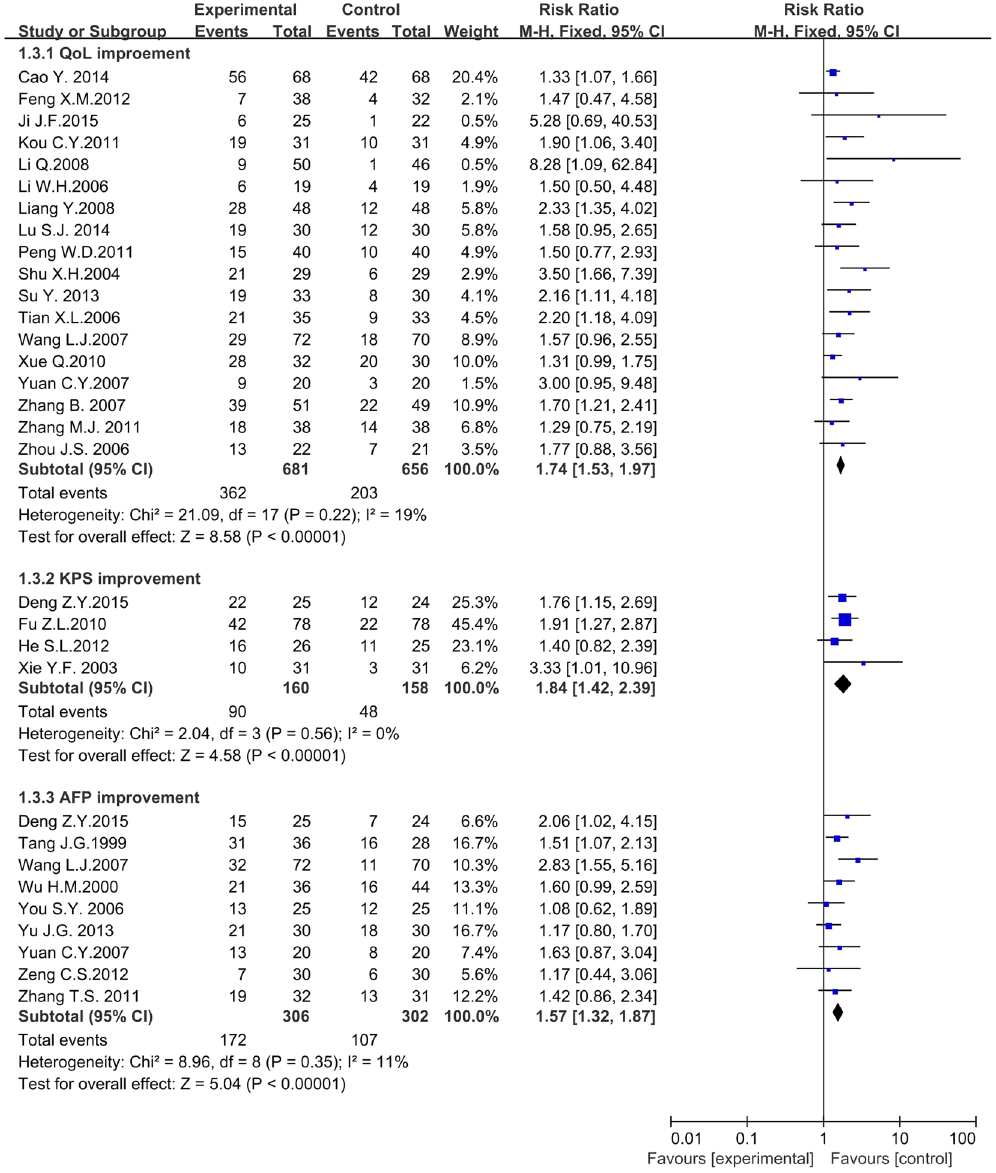
Figure 6. The forest plot of QoL scores, KPS and AFP improvement for traditional insect Chinese medicine and the related preparation combined chemotherapy versus chemotherapy alone (QoL: Quality of life; KPS: Karnofsky performance scores; AFP: Alpha fetoprotein; M-H : Mantel-Haenszel estimates; CI : Confidence